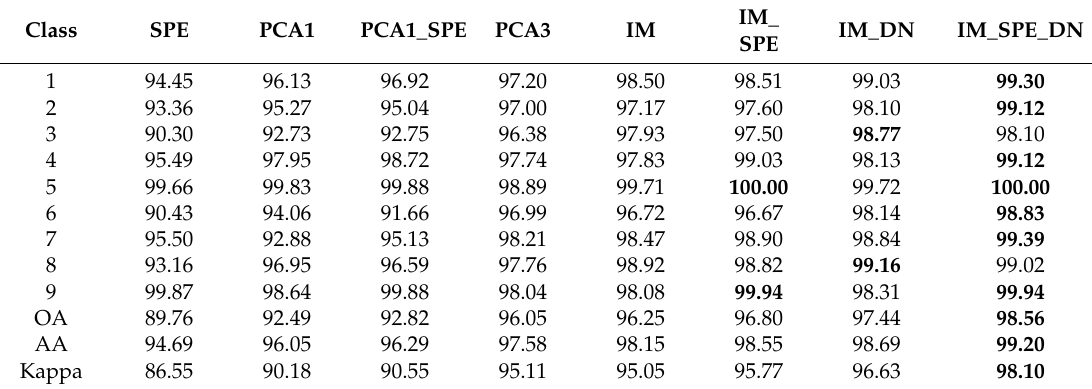
Table 2. The classification results on Pavia University dataset